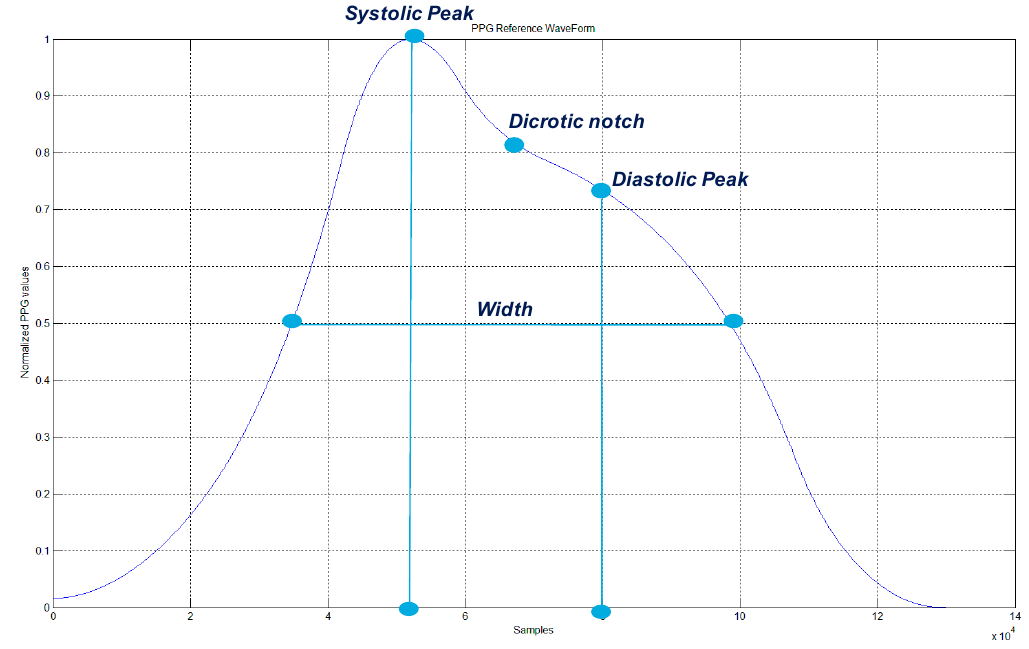
Figure 1. Compliant standard normalized photoplethysmgraphic (PPG) waveform in which some key points related to cardiac activity have been highlighted: systolic, diastolic, and dicrotic peak.